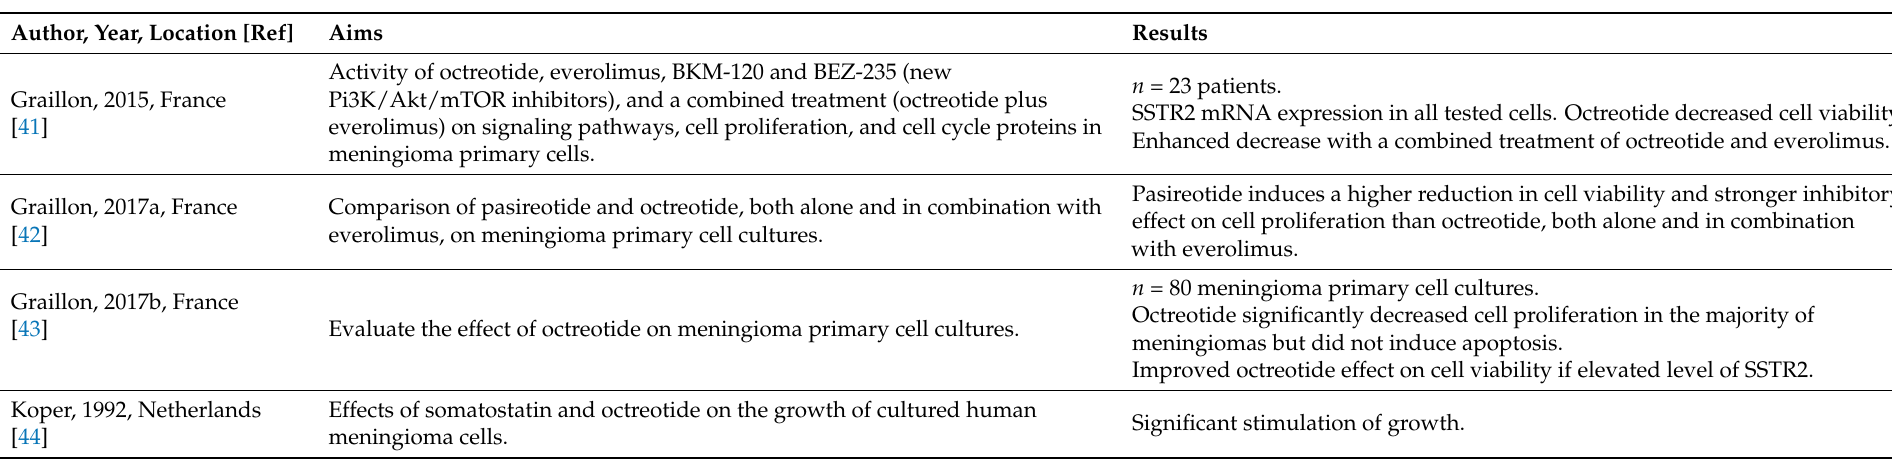
Table 2. Overview of the four included in vitro